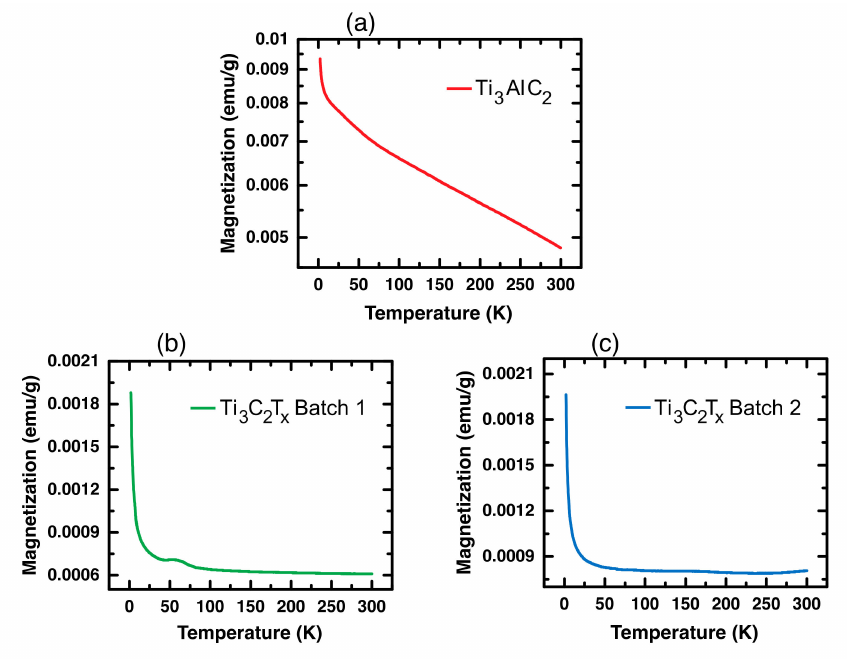
Figure 4. Magnetization versus temperature at 1000 Oe for ( a ) Ti 3 AlC 2 , ( b ) LiF/HCl etched Ti 3 C 2 T x Batch 1 and ( c ) Batch 2